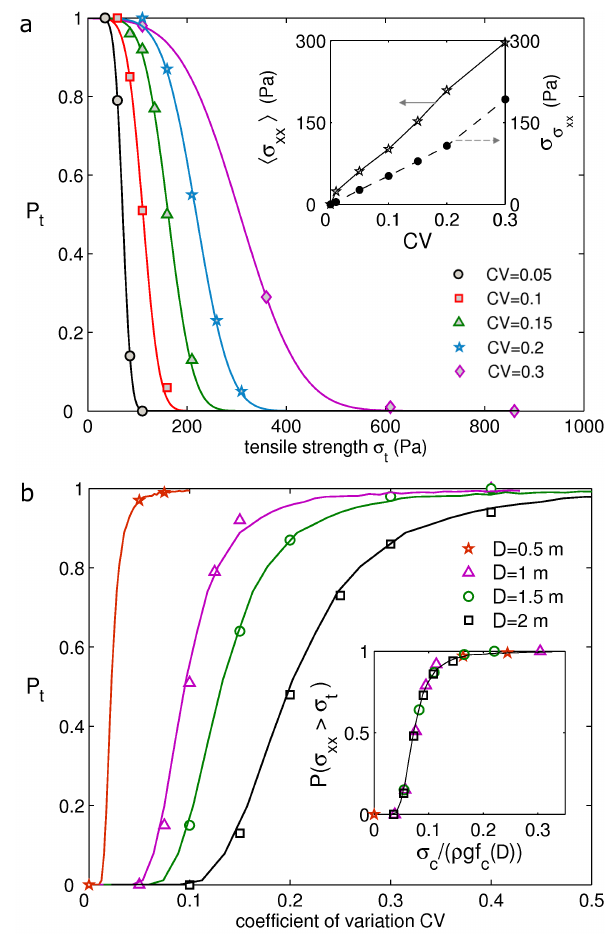
Figure 3. (a) Probability of slab tensile failure P t within the sim- ulated system (partial-slope release) as a function of the tensile strength σ t for different values of the coefficient of variation CV and for a constant correlation length (cid:15) = 2m, a constant slab thick- ness D = 1m, slab density ρ = 250kgm − 3 and a Young modulus E = 1MPa. In the inset, the average tensile stress (cid:104) σ xx (cid:105) and its stan- dard deviation σ are represented as a function of CV. (b) P t is σxx represented as a function of CV for different slab thickness values, a tensile strength σ t = 100Pa and the same value of the other param- eters as in (a) . In the inset, the tensile failure probability P t is repre- sented vs. the standard deviation scaled by f c (D) = 0 . 64 D − 0 . 17 (in